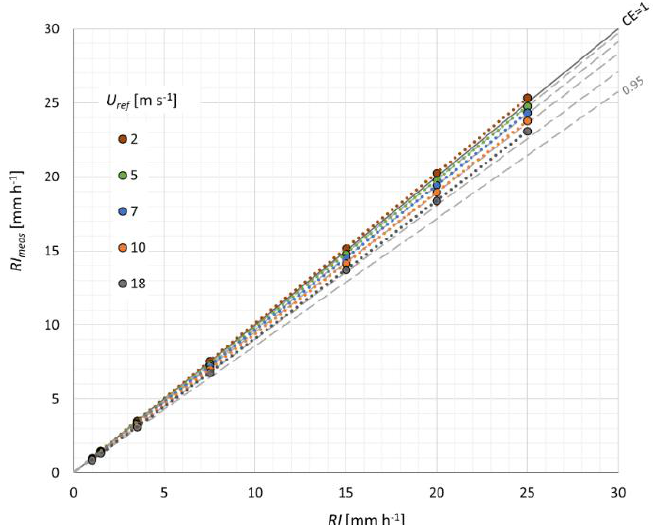
Figure 10. Adjustment curves (dotted lines) for the Casella cylindrical gauge and linear curves at constant CE values (dashed lines). Circles indicate the results of the performed numerical simulations and are colour-coded according to the wind speed ( 𝑈 𝑟𝑒𝑓 ).